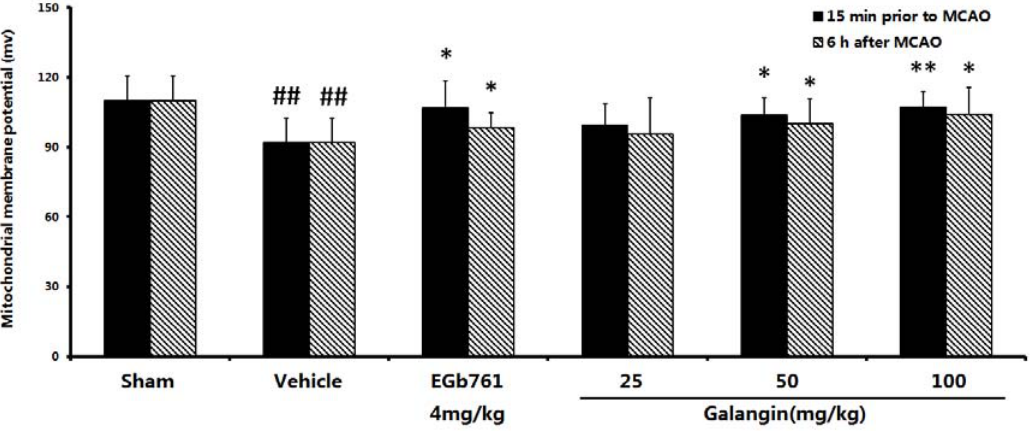
Figure 6. Effects of galangin on the mitochondrial membrane potential caused by MCAO. EGb761 and galangin were both administered by i.g. 15 min prior to MCAO and 6 h after MCAO. The values were expressed as the mean ± SD (n = 10), and the data were analyzed by one-way ANOVA. ## p < 0.01, # p < 0.05 versus the sham group; ** p < 0.01, * p < 0.05 versus the vehicle control.